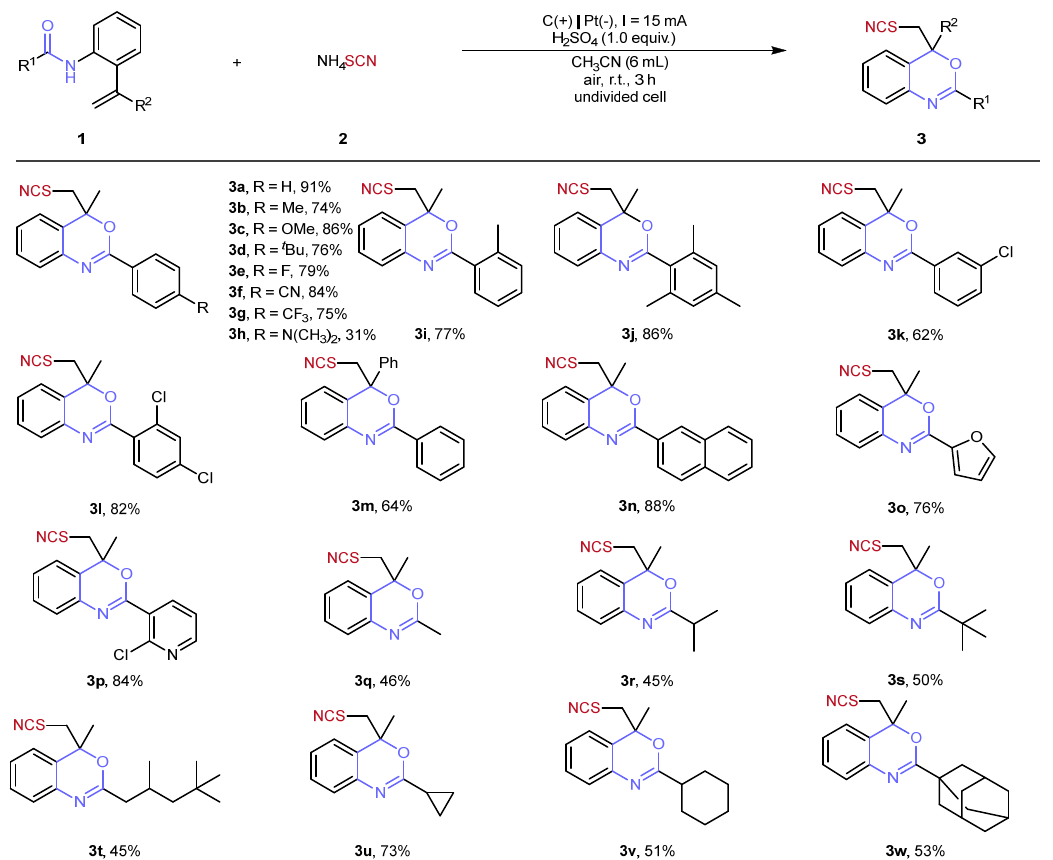
Scheme 2 . Scope of substrates. Reaction conditions: carbon rod anode, platinum plate cathode, constant current = 15 mA, 1 (0.3 mmol), 2 (0.9 mmol), H 2 SO 4 (0.3 mmol), CH 3 CN (6.0 mL), air, 3 h.